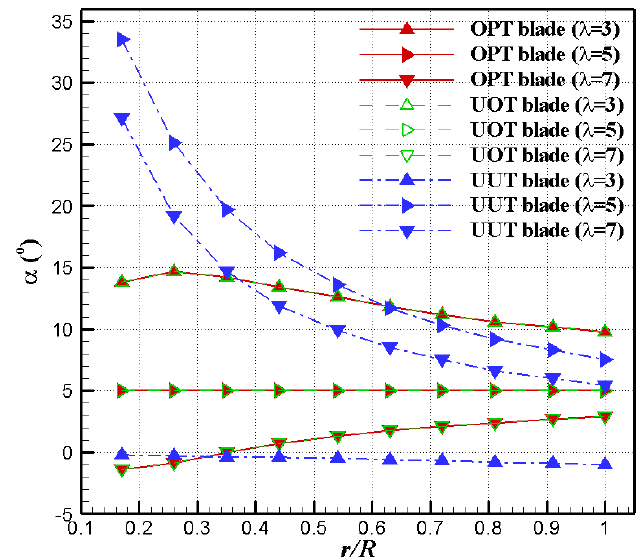
Figure 4. Airfoil data calculated from XFoil with N